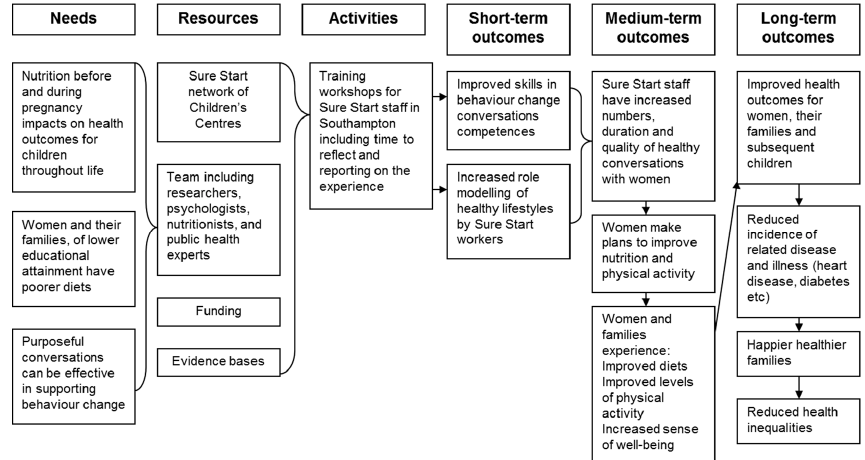
Figure 1. Logic model for the Southampton Initiative for Health, an intervention to train SureStart Children’s Centre staff in Healthy Conversation Skills in order to improve the diets, physical activity levels and well-being of women of child-bearing